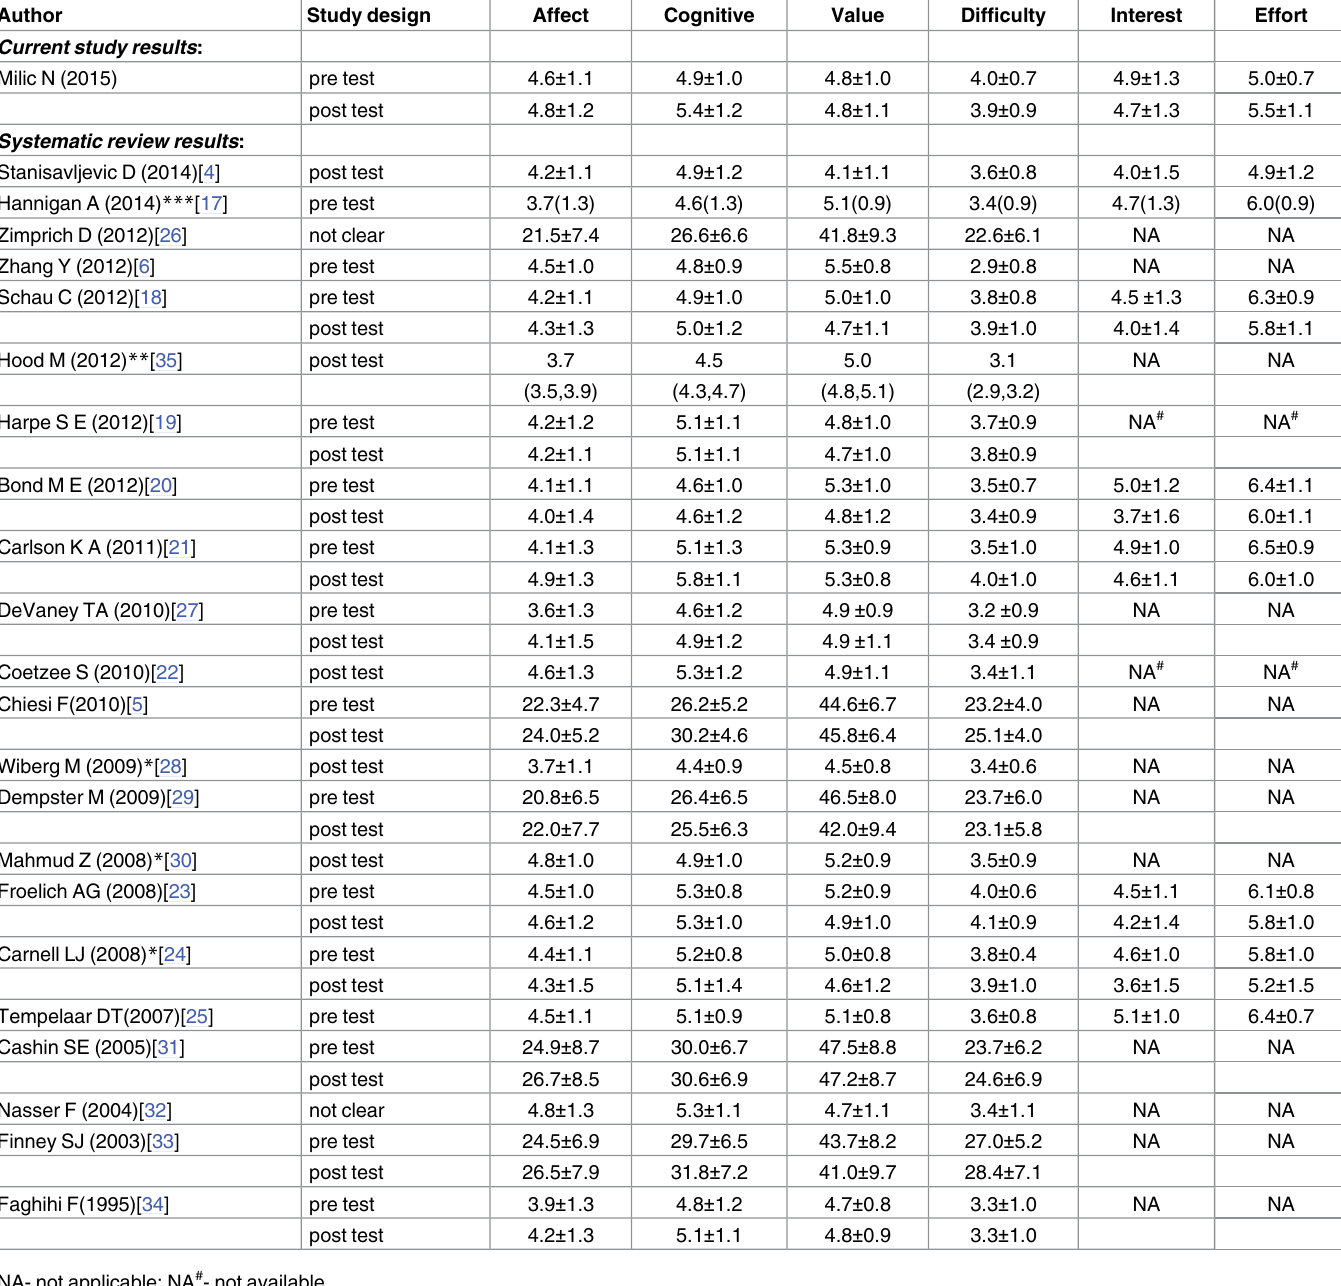
Table 1. Descriptivestatistics of student attitudes towards